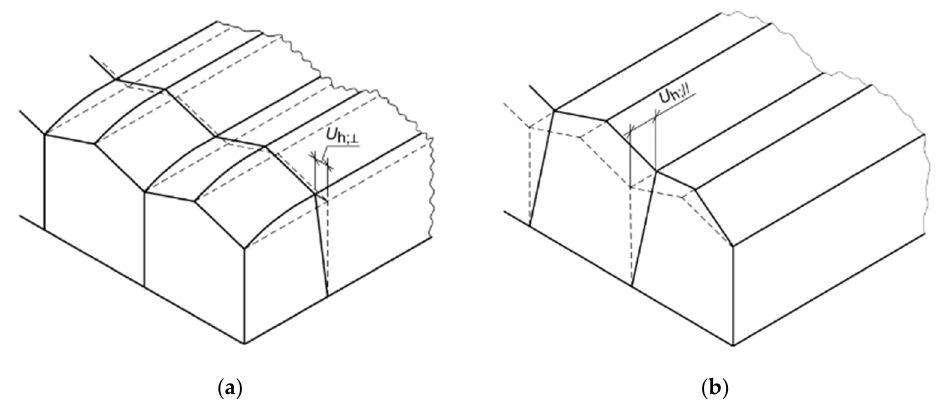
Figure 15. Horizontal displacement ( a ) perpendicular and ( b ) parallel to the gutter. Table 7. Limits of horizontal displacements.